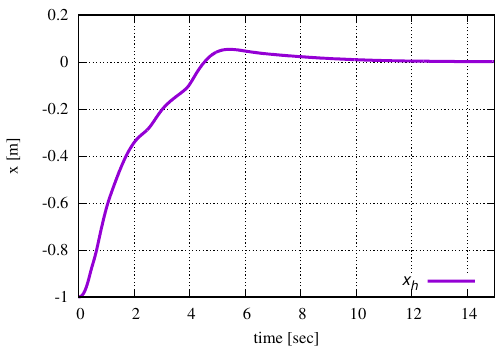
Figure 29. Case 3: Time variation of the x coordinate of the head position.